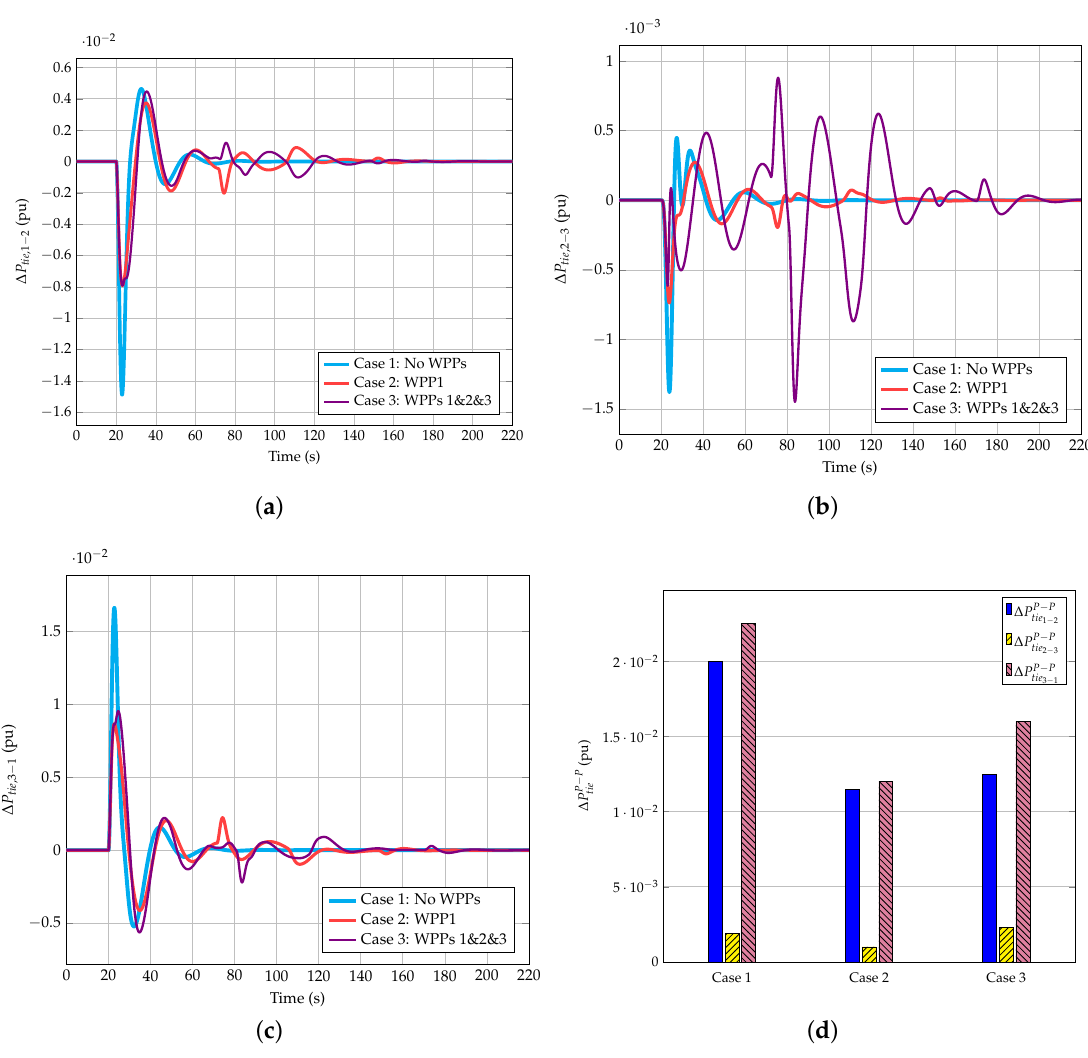
Figure 13. Area 1 under power imbalance ( ∆ P L ,1 ): tie-line power comparison; ( a ) tie-line power variation between Areas 1 and 2; ( b ) tie-line power variation between Areas 2 and 3; ( c ) tie-line power variation between Areas 3 and 1; ( d ) comparison among peak-to-peak tie-line power variation